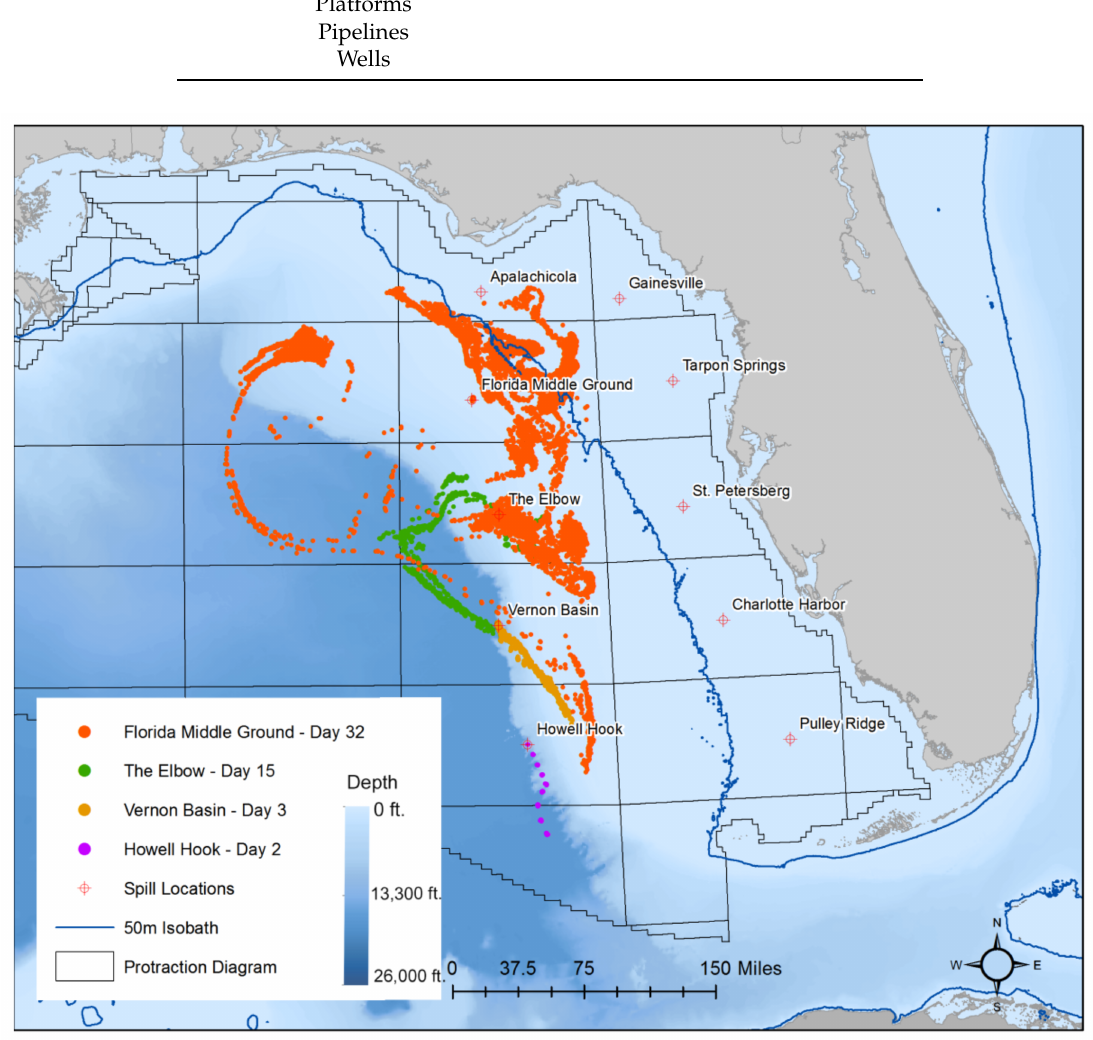
Figure A1. The day in which the oil particles begin to be pulled into the loop current for four out of the five western